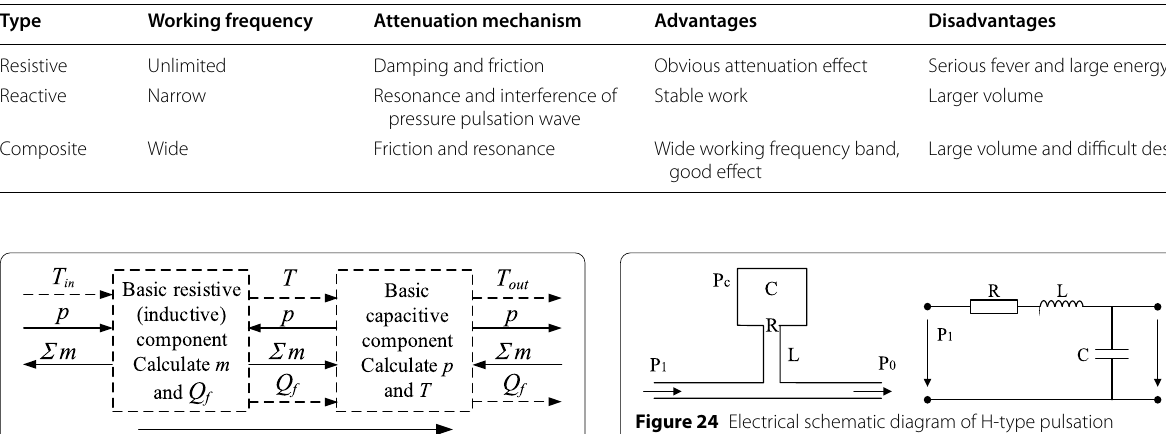
Table 1 Characteristics of various pressure pulsation attenuators